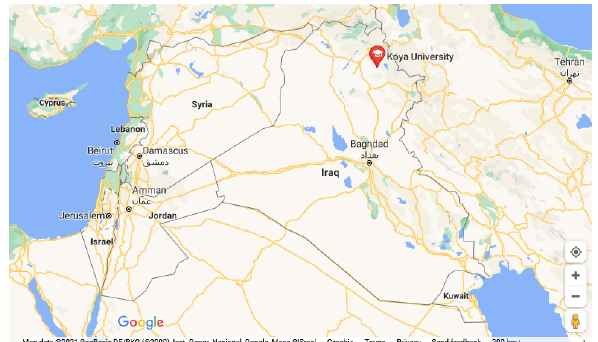
Figure 1. North Iraqi Kurdistan, Koya